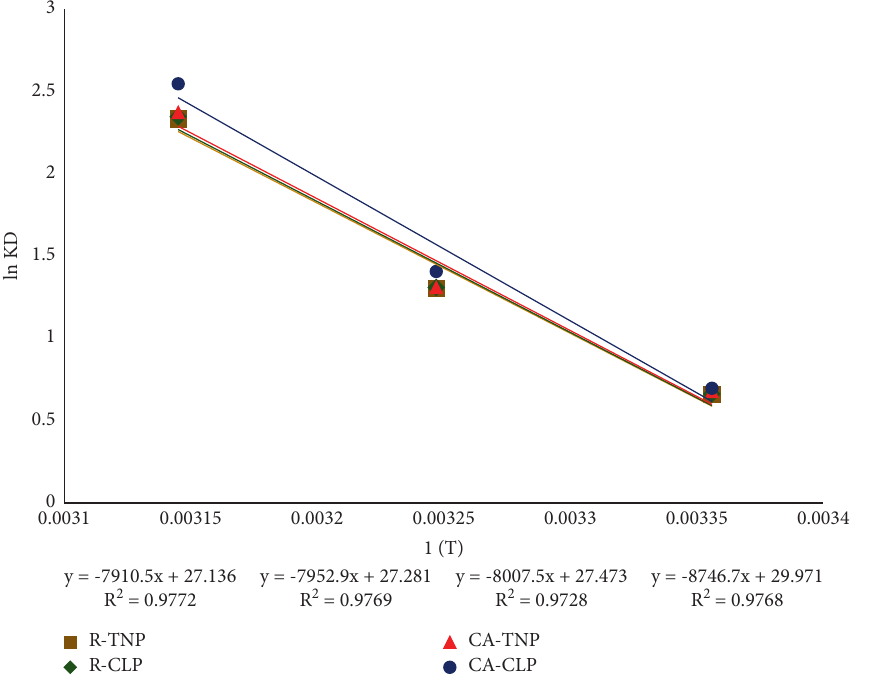
Figure 17: Comparison of thermodynamic parameters of BGD adsorption. Table 4: A comparative study of kinetic parameters for the detoxification of